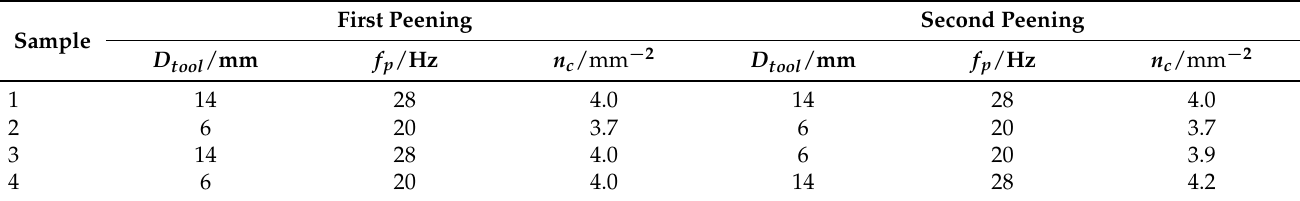
Table 2. Experimental